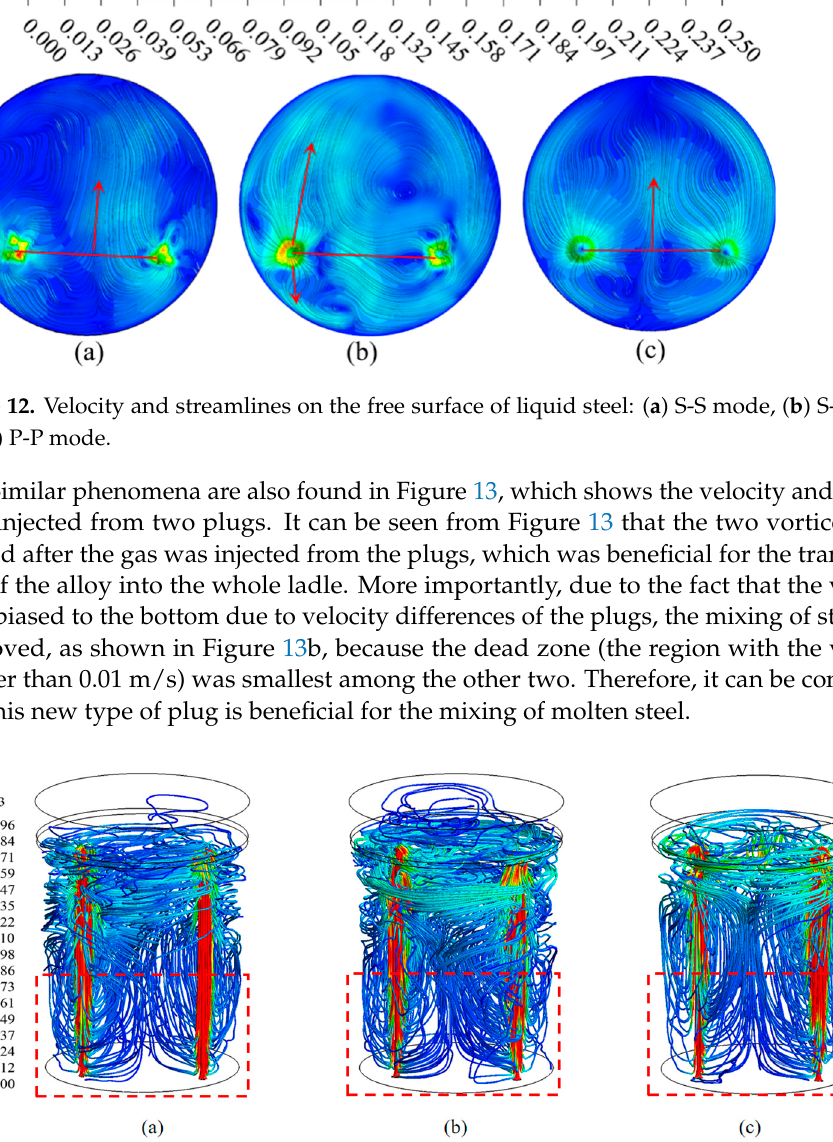
Figure 13. Velocity and streamlines in ladle with different plugs: ( a ) S ‐ S mode, ( b ) S ‐ P mode, and ( c ) P ‐ P mode.